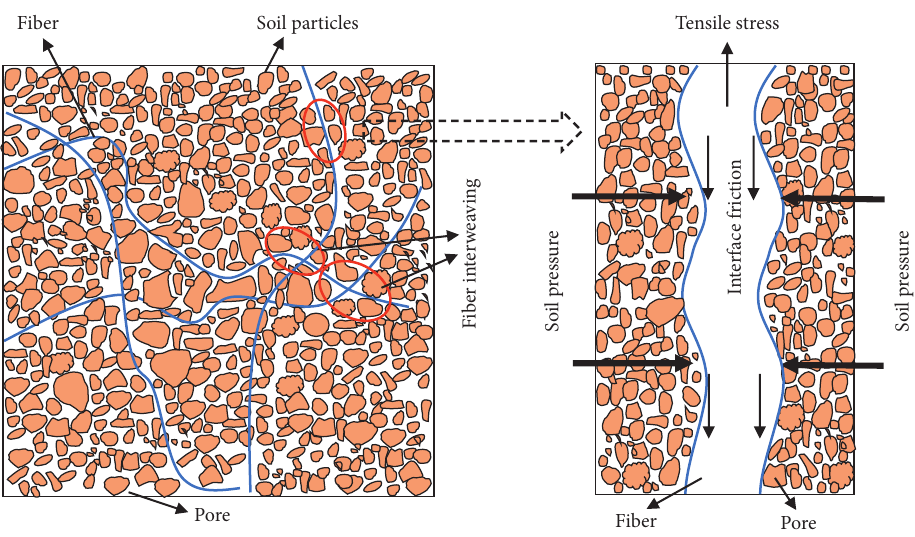
Figure 11: Schematic diagram of fiber-reinforced